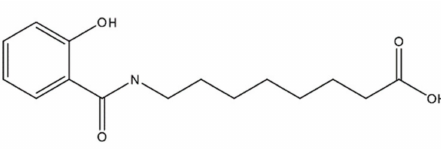
Figure 8. Molecular structure of 8-((2-hydroxybenzoyl)amino)octanoate, also referred to as